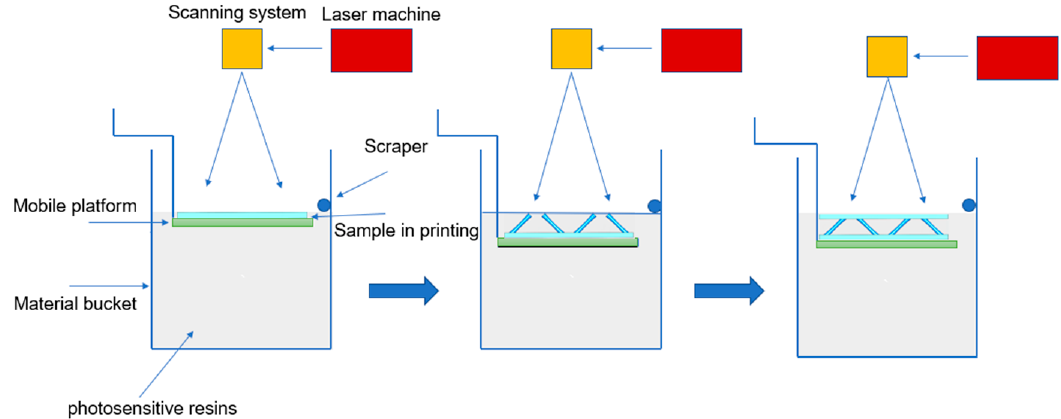
Figure 3. 2-D lattice structure with variable cross-section core shaping technology.